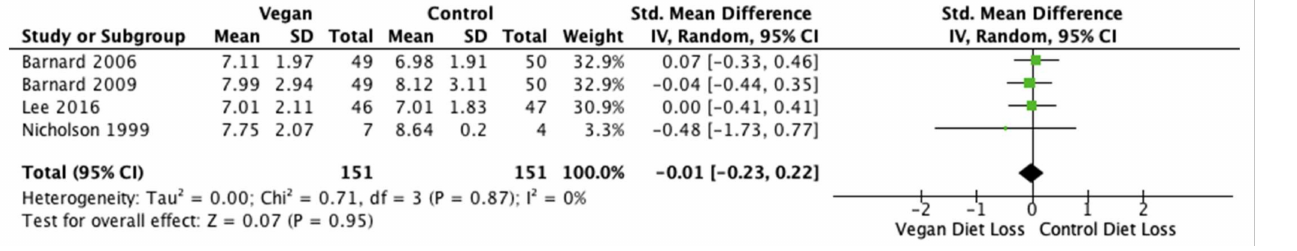
Figure 5. Forest plot comparing mean fasting glucose levels after the consumption of low-fat vegan and control diets [28,40,41,46].